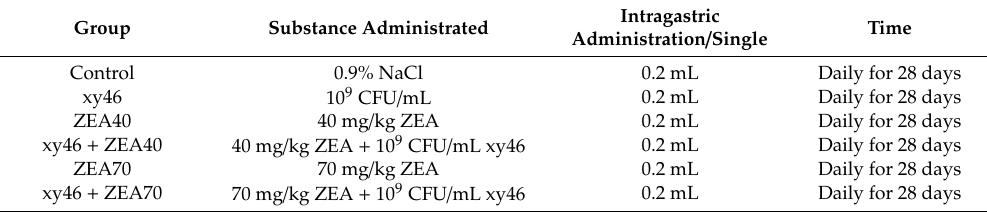
Table 2. Animal test